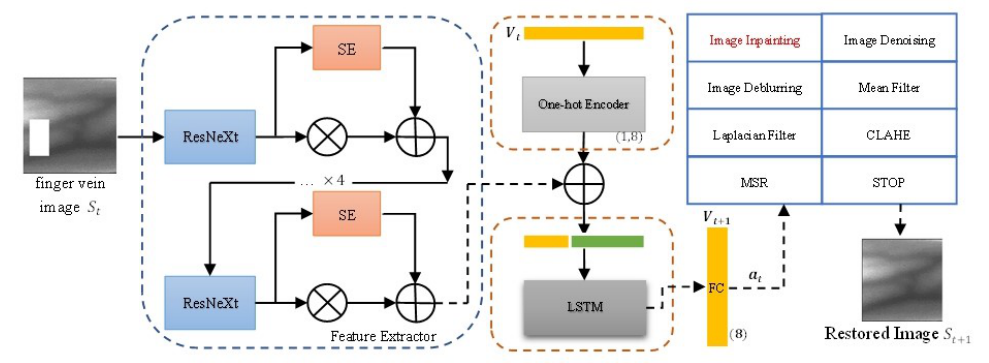
Figure 6. The DRL-FVRestore architecture figure at the step t